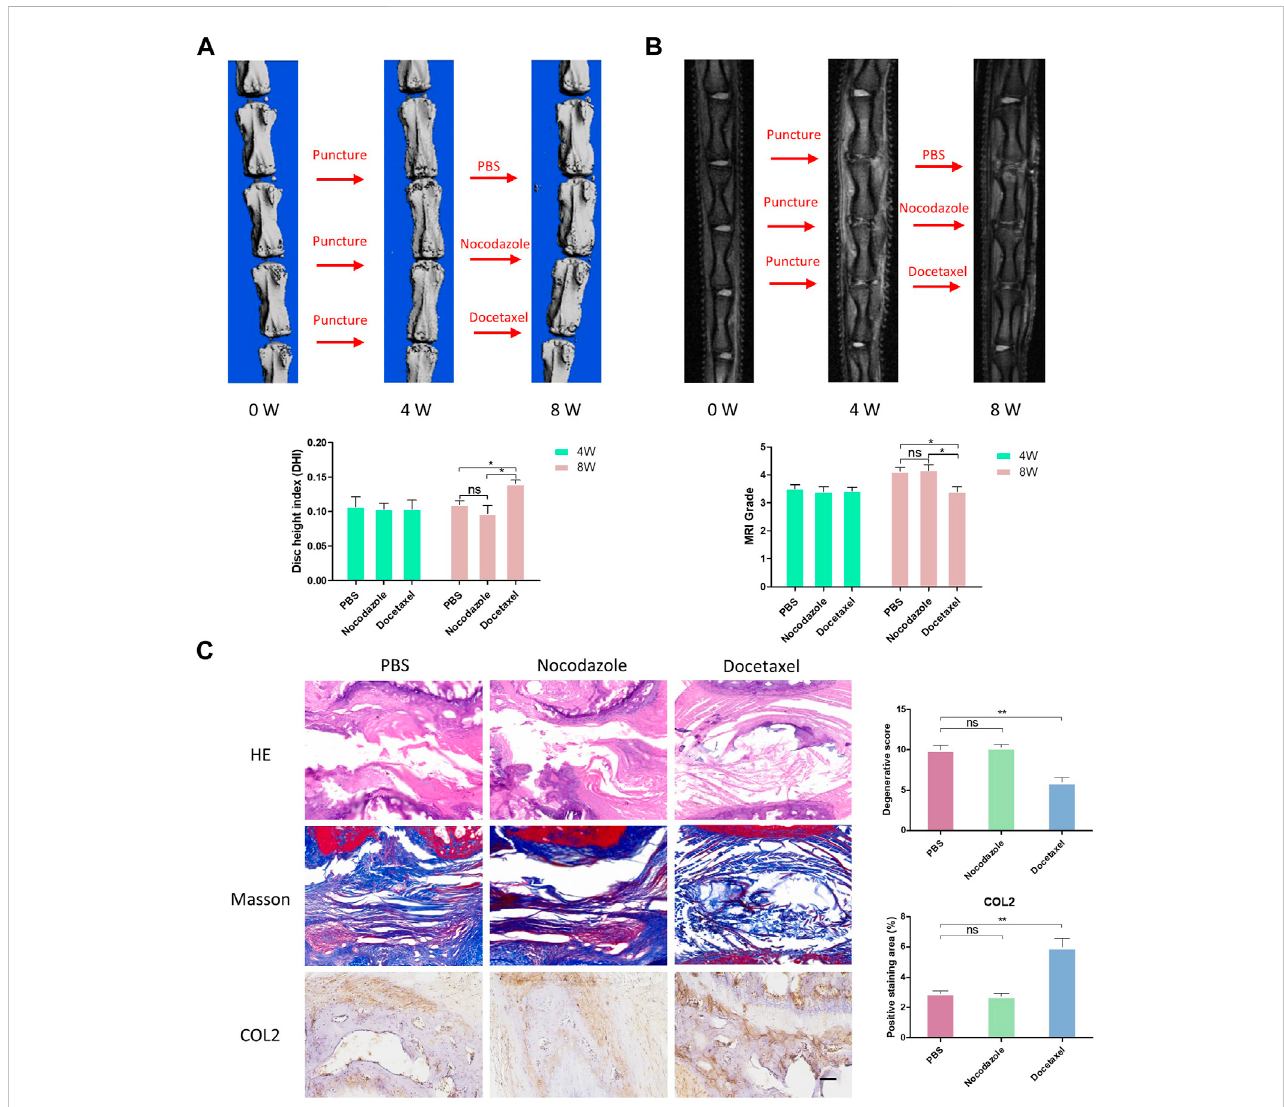
FIGURE 7 MT stabilization alleviates intervertebral disc degeneration (IDD) by promoting the synthesis of COL2 in vivo . (A) After 4 weeks of acupuncture and 4 weeks of treatment with PBS, nocodazole, and docetaxel, 3D micro-CT reconstruction and disc height of rat caudal IVD were collected and measured. (B) After 4 weeks of acupuncture and 4 weeks of treatment with PBS, Nokotazol and docetaxel, MRI and disc degenerative degree (low signal ratio in disc) of ratcaudalIVDwerecollectedandmeasured. (C) HEstaining,MassonstainingandCOL2immunohistochemistrystainingofratcaudalIVDaftertreatment with PBS, Nocodazole and Docetaxel for 4 weeks. Data are represented as the mean ± SEM. * p < 0.05, ** p < 0.01, *** p <